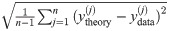
cAMP binding for different CRP mutants.In addition to the wild type CRP subunit (denoted WT), the mutation D53H (denoted D) and the mutation S62F (denoted S) can be applied to either subunit as indicated by the subscripts in the legend. (A) Curves were characterized using the MWC model, Eq (1). The D subunit increases CRP’s affinity for cAMP while the S subunit decreases this affinity. (B) Asymmetrically mutating the two subunits results in distinct cAMP binding curves. The data for the WT/D mutant lies between the WT/WT and D/D data in Panel A, and analogous statements apply for the WT/S and D/S mutants. (C) The fraction of CRP in the active state. Within the MWC model, mutants with an S subunit will be inactive even in the limit of saturating cAMP. (D) The symmetric and (E) asymmetric mutants can also be analyzed using the KNF model, Eq (6), resulting in curves that are similar to those found by the MWC model. (F) The KNF model predicts that all CRP mutants will be completely active in the limit of saturating cAMP. The (corrected) sample standard deviation 1n-1∑j=1n(ytheory(j)-ydata(j))2 equals 0.03 for the MWC model and 0.05 for the KNF model, and the best-fit parameters for both models are given in Table 1. Data reproduced from Ref. [29].